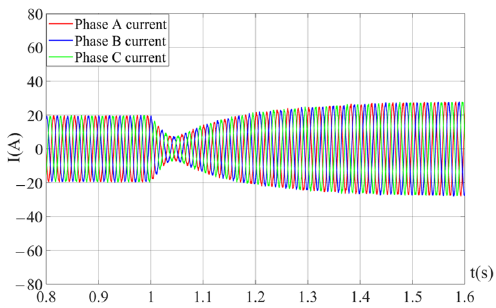
Figure 11. Three ‐ phase voltages of AC bus (Group A).